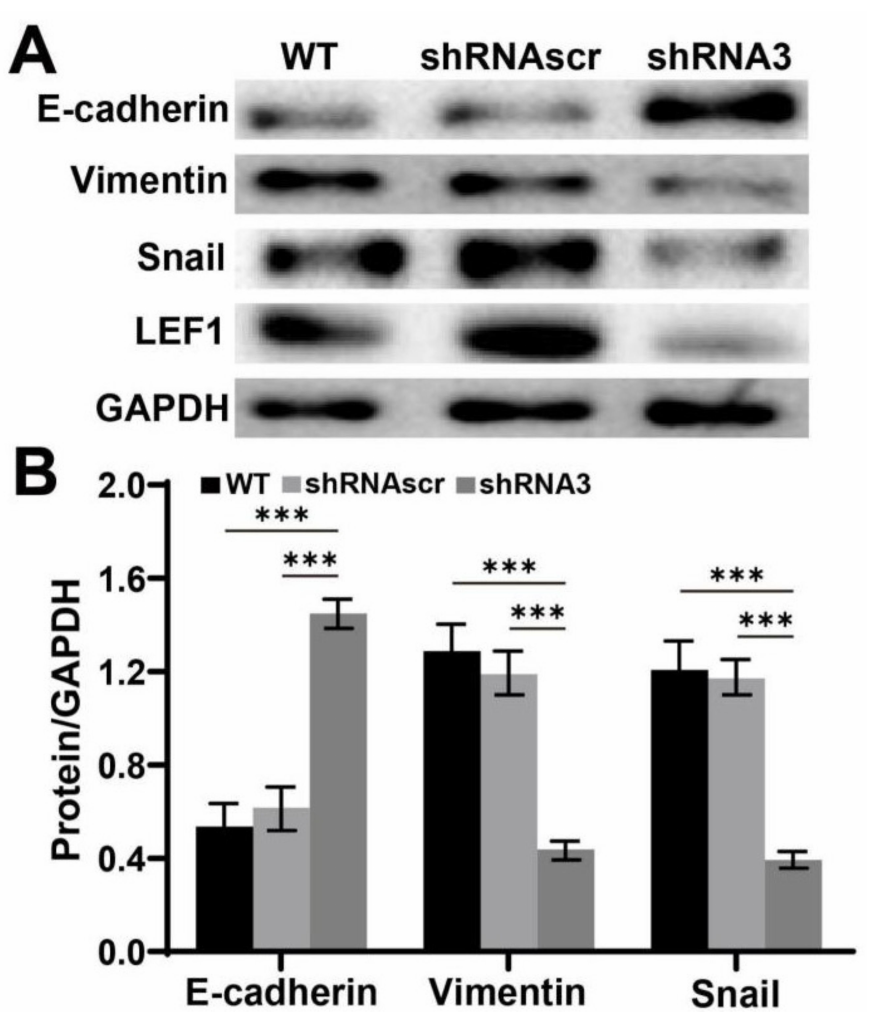
Figure 5. Knockdown of LEF1 inhibited the expression of EMT-relevant genes in caco2 cells. ( A , B ): EMT-associated gene expression analysis by Western blot. *** p <